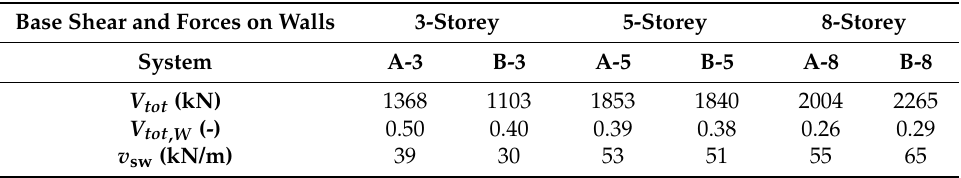
Table 4. Base shear forces at ultimate limiting state (ULS).